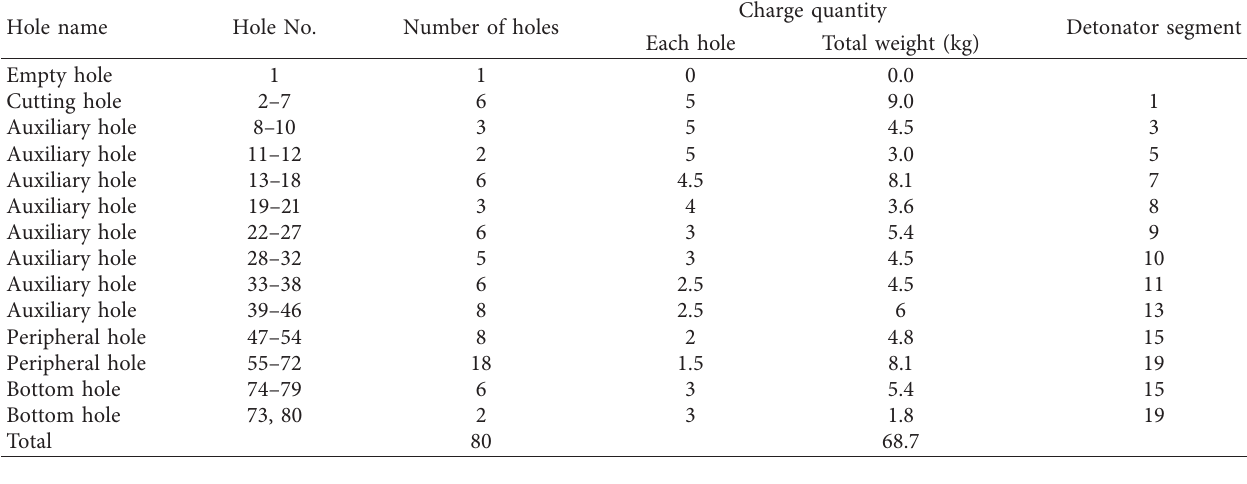
Table 2: Blasting parameters scheme [24].